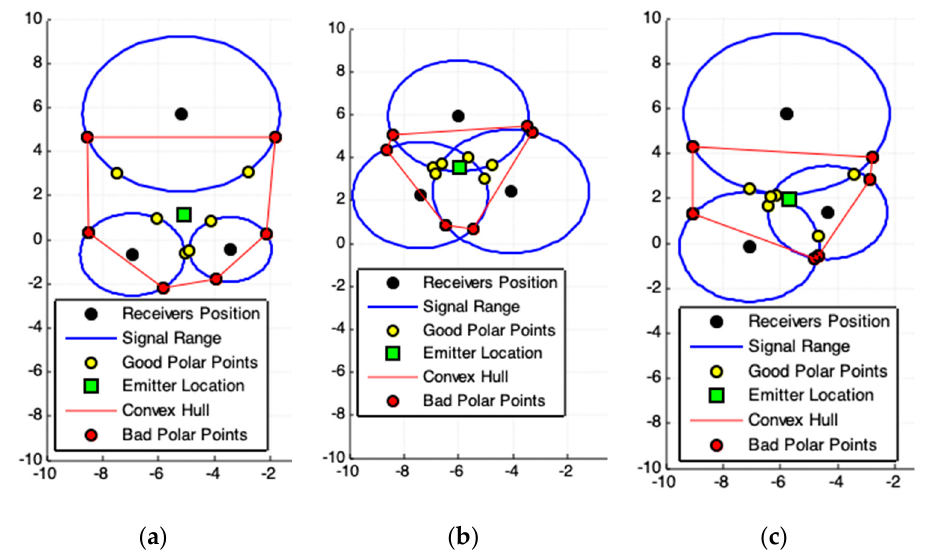
Figure 5. Results produced by Convex Hull Centroid Model (CHC). ( a , b ) highlight the possible presence of noise in acquired data. ( c ) Represents the best case for acquired data. For this case, is better applying the exact solution provided by Section 2.1.